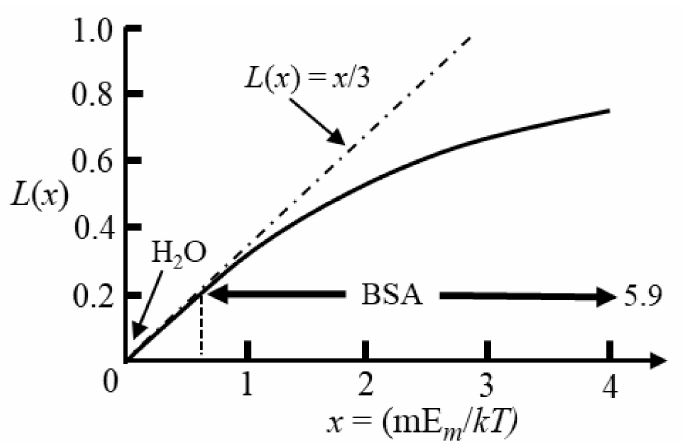
Figure 9. The average orientation of a single dipole along the direction of an applied field is given by the Langevin function (L(x) = coth x − 1/x) [18,19]. Fields of ~10 6 to 10 7 V/m are used in protein DEP experiments [4,5]. Polar molecules typically have dipole moments less than 5 debye units (e.g., 1.8 D for H 2 O) so that x << 1. Globular proteins have large dipole moments and as shown for BSA (m = 710 D [54]) saturation of its polarization can occur in DEP